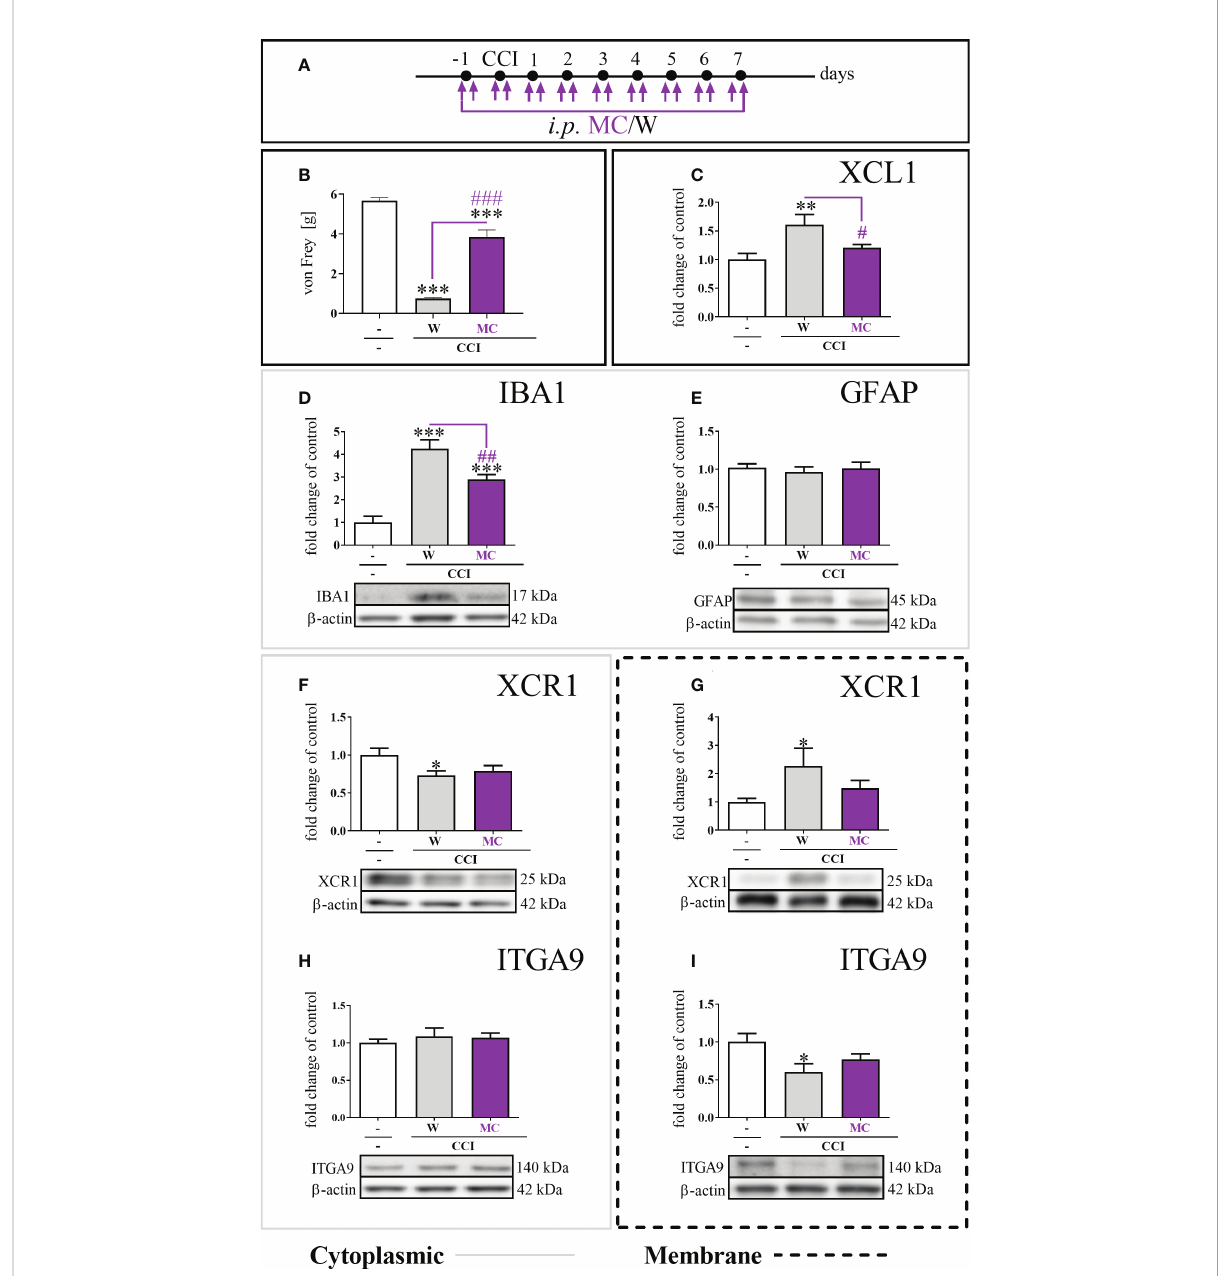
FIGURE 4 The in fl uence of repeated (preemptive and then twice daily for 7 days) minocycline (MC) administration (A) , at a dose of 30 mg/kg, on mechanical hypersensitivity (B) ; XCL1 protein level in the cytoplasmic fraction by ELISA (C) , IBA1 (D) , GFAP (E) , XCR1 (F) , and ITGA9 (H) protein levels in the cytoplasmic fraction by Western blot; XCR1 (G) and ITGA9 (I) protein levels in the membrane fraction by Western blot, seven days after chronic constriction injury (CCI) of the sciatic nerve in mice. The data are presented as the mean fold changes relative to the control ± SEM (n =5 – 14). The results were evaluated using one-way ANOVA followed by Bonferroni ’ s post hoc test for comparisons of selected pairs; ✽ p<0.05; ✽✽ p<0.01; ✽✽✽ p<0.001 indicate signi fi cant differences between the naive vs. W – /MC – treated groups; # p<0.05; ## p<0.01; ### p < 0.001 indicate signi fi cant differences between the W – vs. MC – treated groups. “ - ”– naive; “ W ” – vehicle (water for